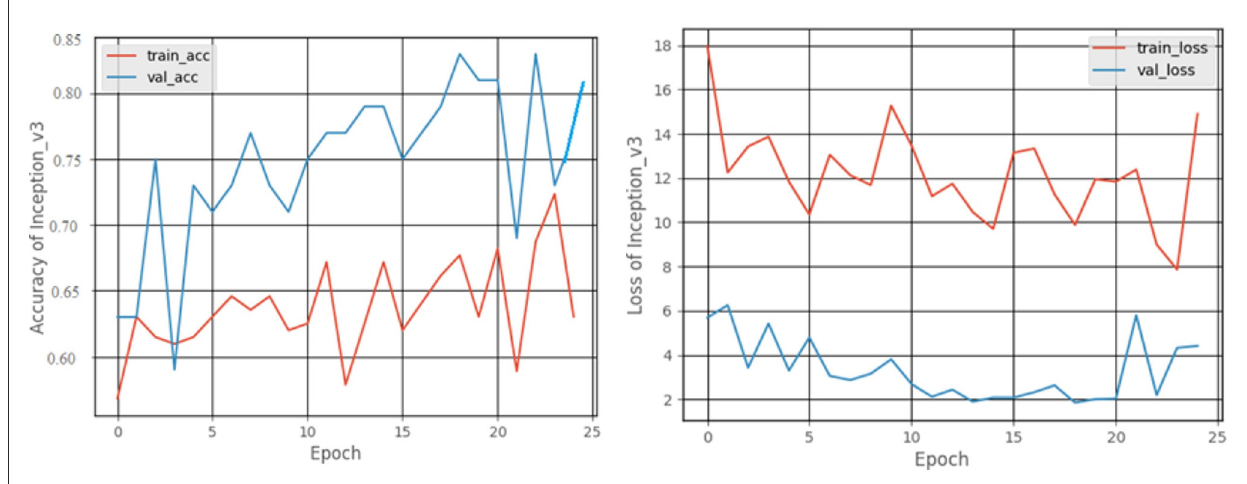
FIGURE13 Accuracy and loss graphs of Inception V3